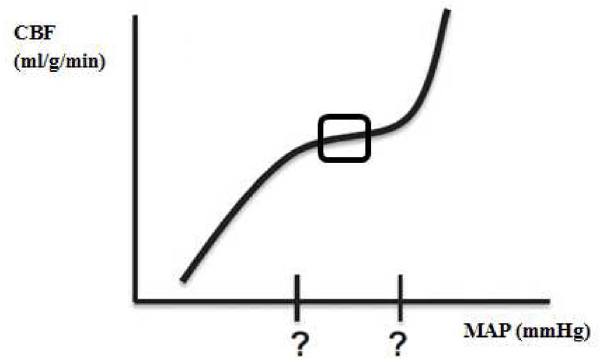
Figure 3. The autoregulation curve may vary from the classic depiction of autoregulation, with unknown limits of autoregulation (question marks), and an optimal mean arterial blood pressure (square). CBF, cerebral blood flow; MAP, mean arterial blood pressure.